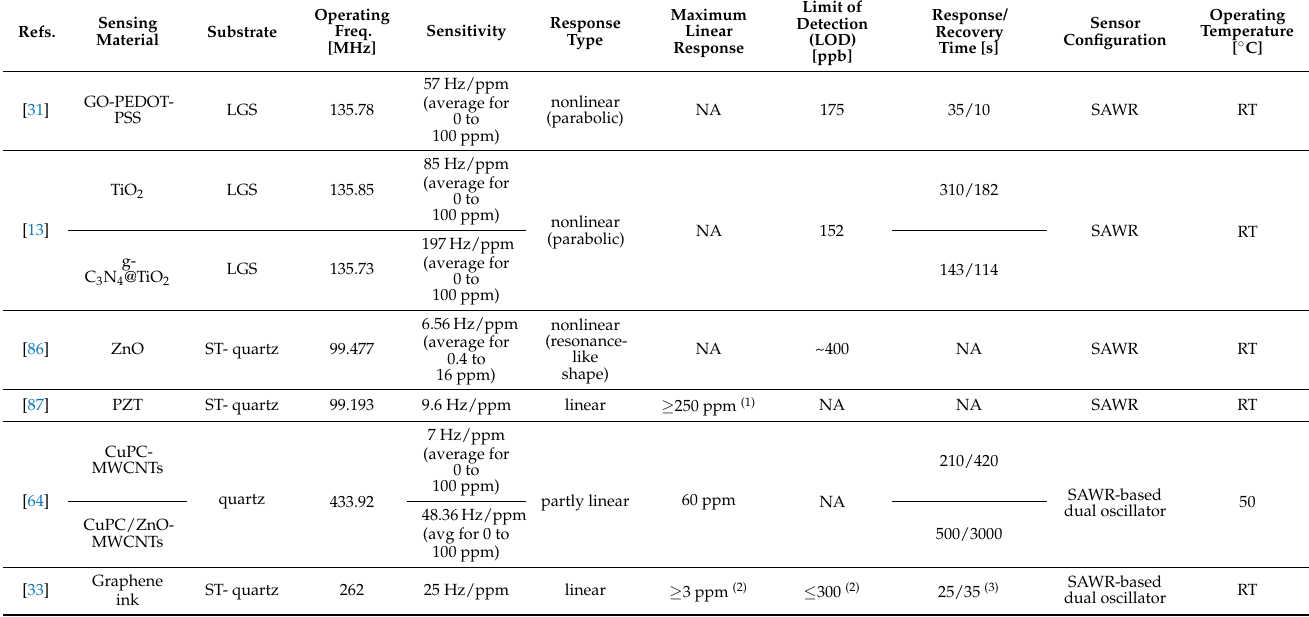
Table 2. Selected published work in SAW resonator configuration for NO 2 detection.